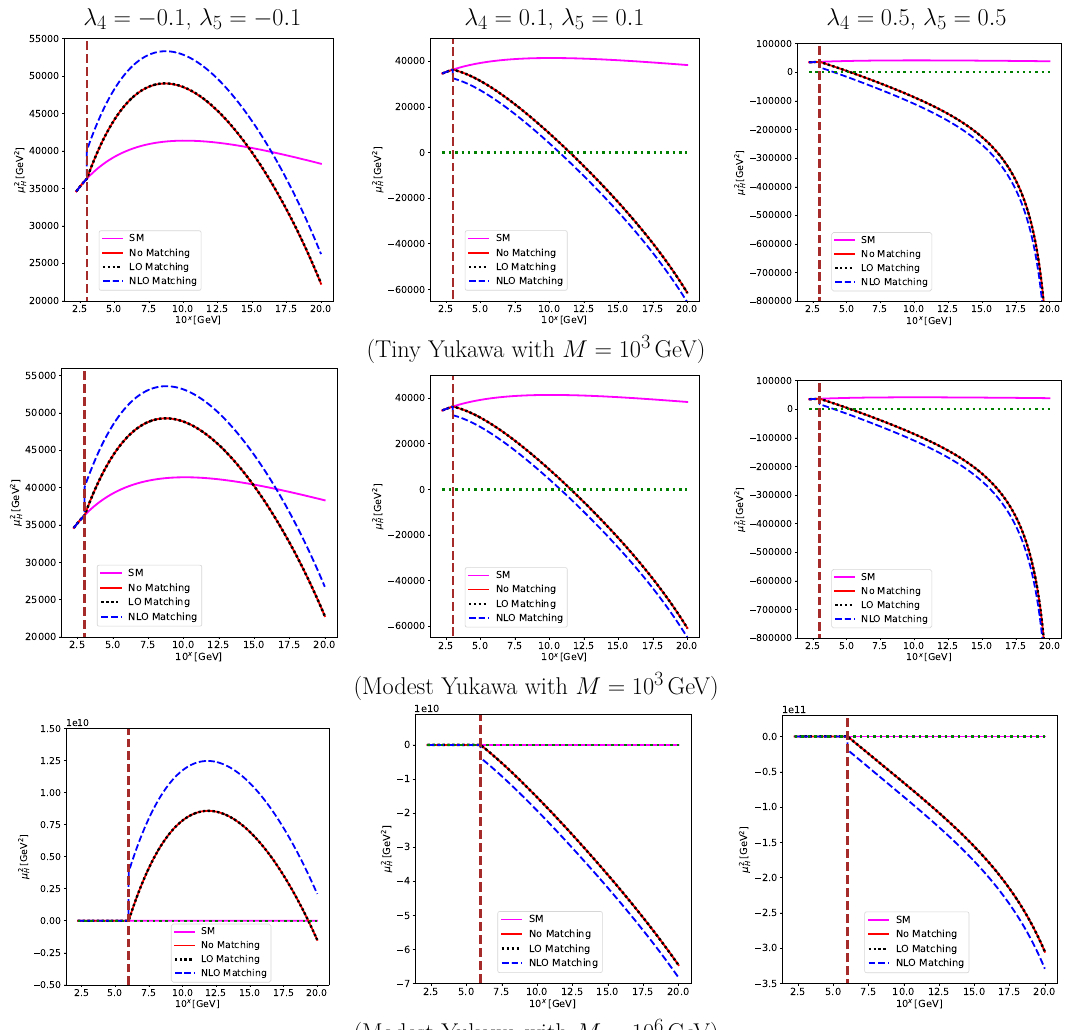
in the type-II seesaw model, where we use the same color codes as those Figure 7 . Running of µ 2 H in figure 5 with the addition of the dotted line in black for the tree-level matching. The first row is for the tiny Yukawa case, and the last two rows are for the modest Yukawa case in table